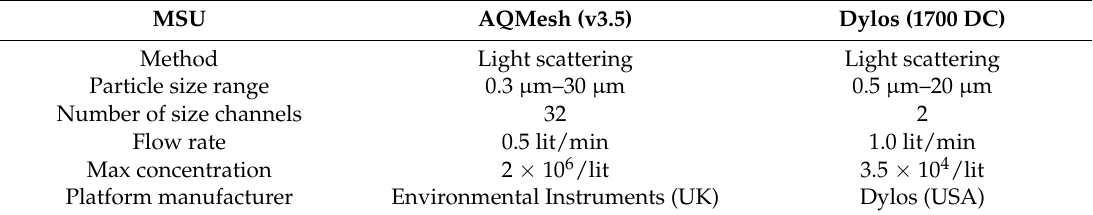
Table 2. Specifications of the stationary MSUs for particle number concentration (PNC) measurement.